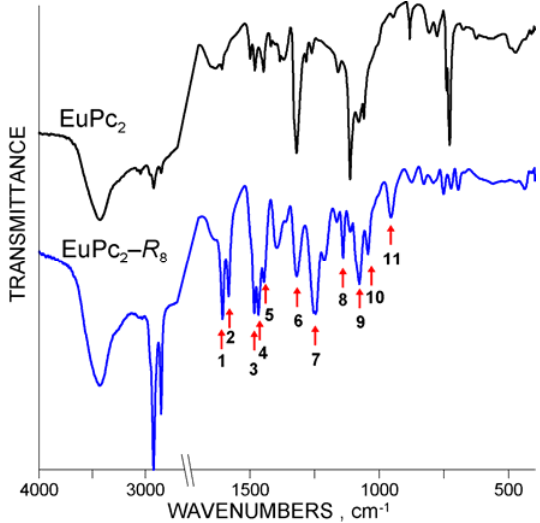
Figure 8. Effect of pentadecylphenoxy-substitution in EuPc (note the X-axis has been broken between 1700 and 2700 cm − 1 for